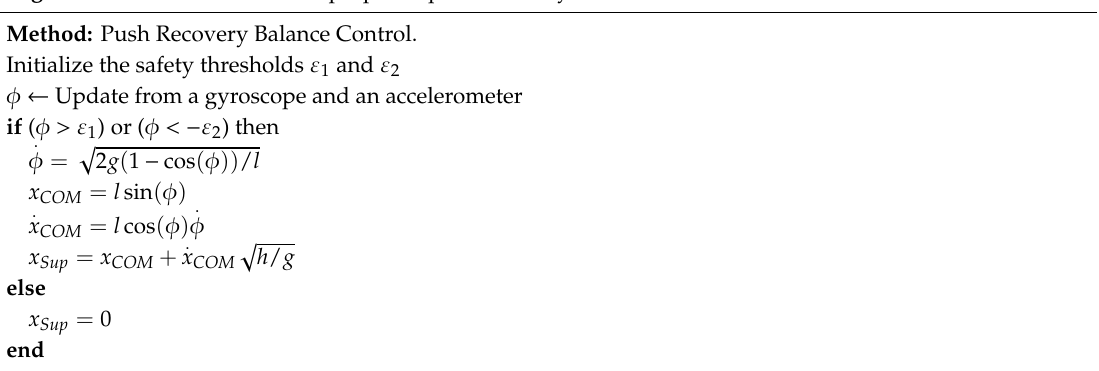
Algorithm 1 Pseudo code of the proposed push recovery balance control. Method: Push Recovery Balance